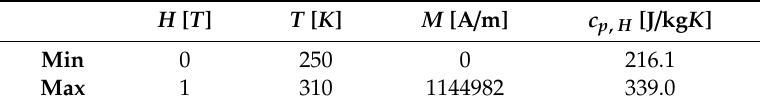
Table A3. Input-target mapping of Gd ANN.